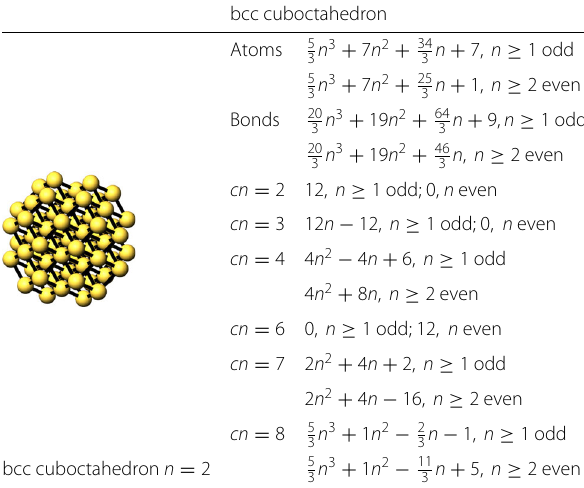
Table 6 Magic formulas for the bcc cuboctahedron